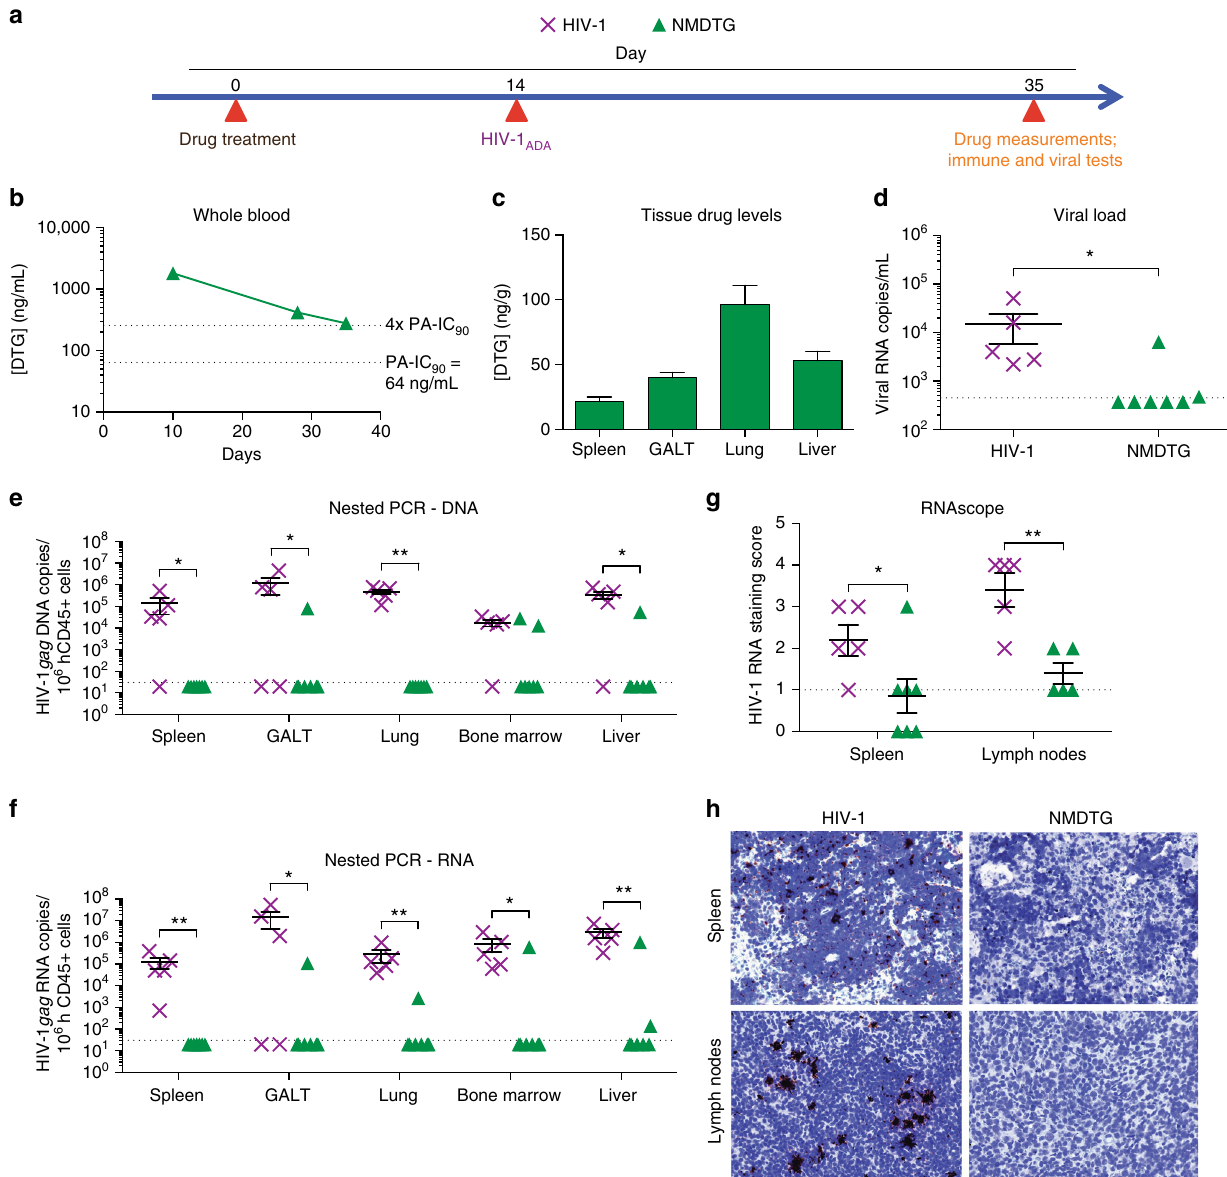
Fig. 6 Protection against HIV-1 challenge in CD34+ humanized mice. CD34+ hematopoietic stem cell (HSC)- reconstituted NSG mice were treated with NMDTG according to the scheme illustrated in a . HIV-1-infected mice without treatment served as positive controls. b Blood DTG concentrations were analyzed by UPLC-MS/MS. Dotted lines indicate the PA-IC 90 (64 ng/mL) and four-times the PA-IC 90 (256 ng/mL). c DTG concentrations were also analyzed in spleen, GALT, lung, and liver samples. d Plasma viral load was measured three-weeks after HIV-1 challenge. e DNA and f RNA semi-nested real-time PCR was performed on spleen, GALT, lung, bone marrow, and liver. g HIV-1 RNAscope was performed on spleen and lymph node sections and scored according to amount of positive staining [0 = no staining or < 1 dot/10 cells, 1 = 1 – 3 dots/cell, 2 = 4 – 9 dots/cell with no, or very few, dot clusters, 3 = 10 – 15 dots/cell and < 10% dots are in clusters, 4 = > 15 dots/cell and > 10% dots are in clusters]. Anything scoring less than or equal to one was considered as background. h Representative HIV-1 RNAscope staining (brown) of spleen (top) and lymph node (bottom) sections are shown. * P < 0.05, ** P < 0. 01. Results are shown as the mean ± SEM of fi ve positive control (5 female) and 7 NMDTG-treated (5 female, 2 male) animals. Results were analyzed by two-tailed Student ’ s t test ( n = 5 HIV-1 control, 7 MDTG; degrees of freedom = NOD/scid-IL-2R γ c null (NSG) mice were reconstituted by intra- challenge, and blood, plasma, and tissues were collected for drug peritoneal (IP) injection of human peripheral blood lymphocytes levels, human T cell counts, viral load, and HIV-1p24 expression. (hu-PBLs) 4 or 19 days post drug treatment generating hu-PBL- Neither NDTG nor NMDTG treatment adversely affected animal NSG, mice. Mice were administered a single IM dose of NDTG or weights (Supplementary Fig. 4a, e). Enhanced levels of viral NMDTG at a concentration of 45 mg/kg DTG-eq. on day 0 restriction were observed by NMDTG over NDTG treatments (Supplementary Fig. 3a) then challenged 10 days post hu-PBL when mice were challenged two or four weeks after a single IM reconstitution with 2 × 10 4 TCID 50 of HIV-1 ADA administered by drug dose. Levels of viral reductions were 3.0-log 10 and 1.2-log 10 in plasma viral load compared to HIV-1 infected controls and IP injection. Animals were euthanized 10 days post HIV-1